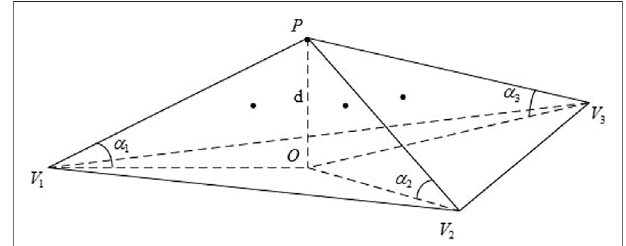
FIGURE 7 | Schematic diagram of the judgement algorithm for the ground